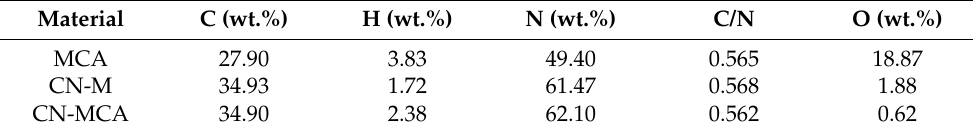
Table 1. Elemental analysis of melamine-cyanurate complex (CN-MCA) materials.